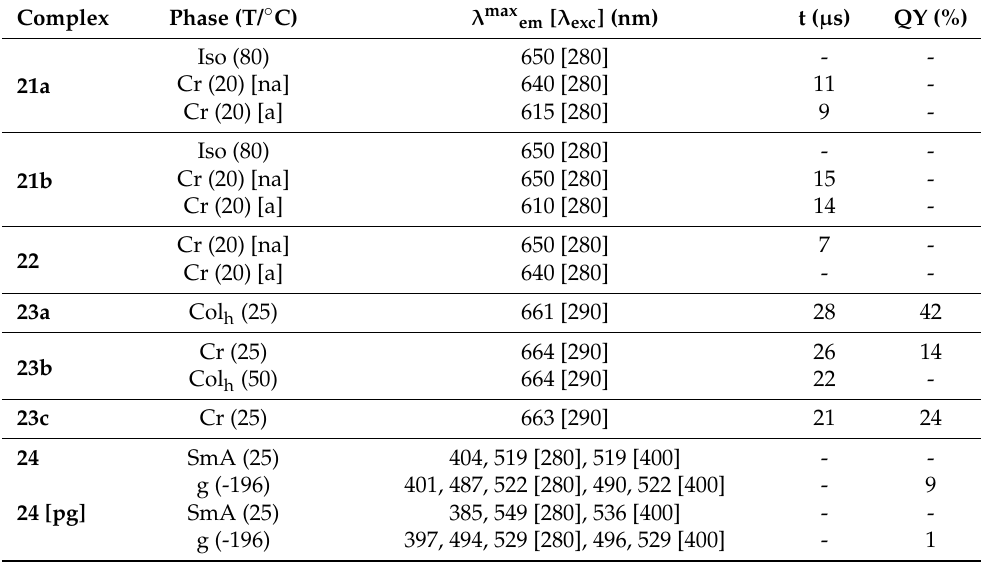
Table 1. Summary of luminescence data for copper(I) metallomesogens reported in [57–60].